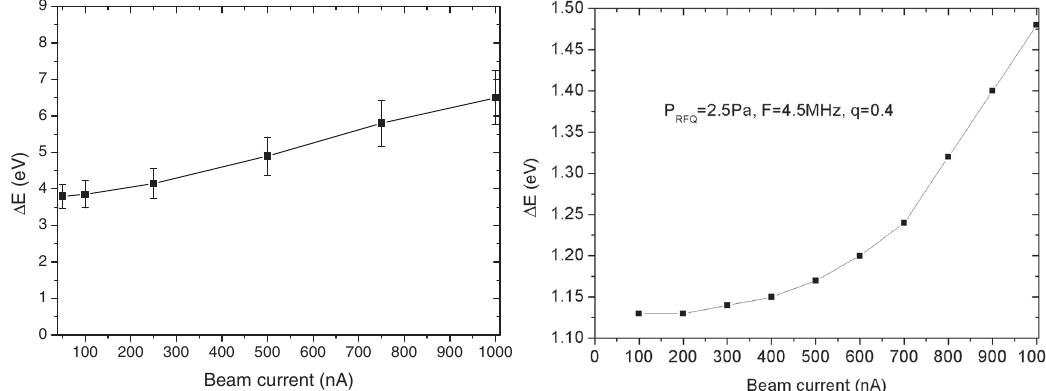
FIG. 7. Illustration of the space charge effect on the longitudinal energy spread with and without μ RFQ and for Mathieu parameter ¼ 2 . 5 Pa: Variation of Δ E as a function of the beam current without μ RFQ (left), variation of Δ E as a function of the q ¼ 0 . 4 and P RFQ beam current with μ RFQ (right).